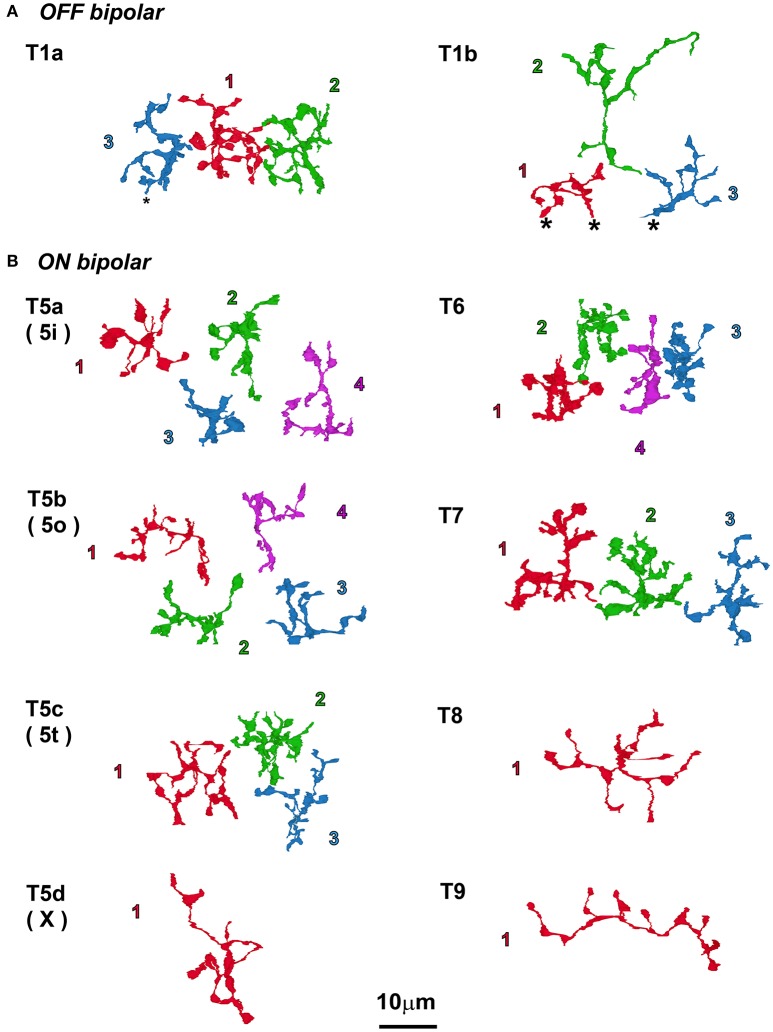
Top view of axon terminal arbors of bipolar cells that all coexist in the same examination area. (A) Only two types of OFF bipolar cells are shown here, so the novel type 1b cell observations are compared with the previously published type 1a cell description (Tsukamoto and Omi, 2014). (B) The eight types of ON bipolar cells; in this area, there was one cell each of types 5d, 8, and 9, and 3–4 cells each for all of the other types. Cells are displayed with the serial numbers used in other figures and colored for clarity. Asterisks (*) indicate the end of the series of electron micrographs.